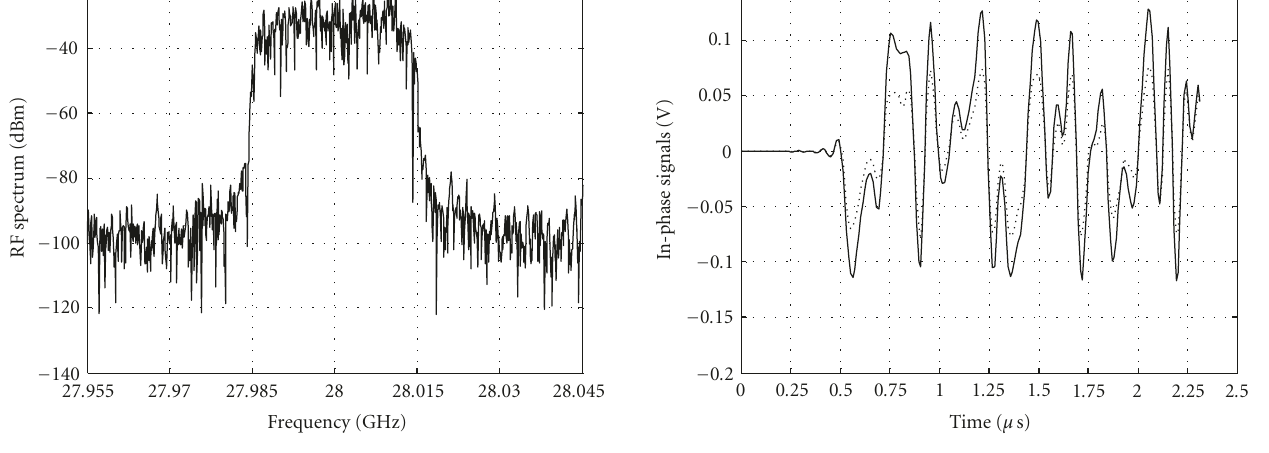
Figure 18: Output spectrum of the modulator at 28GHz.